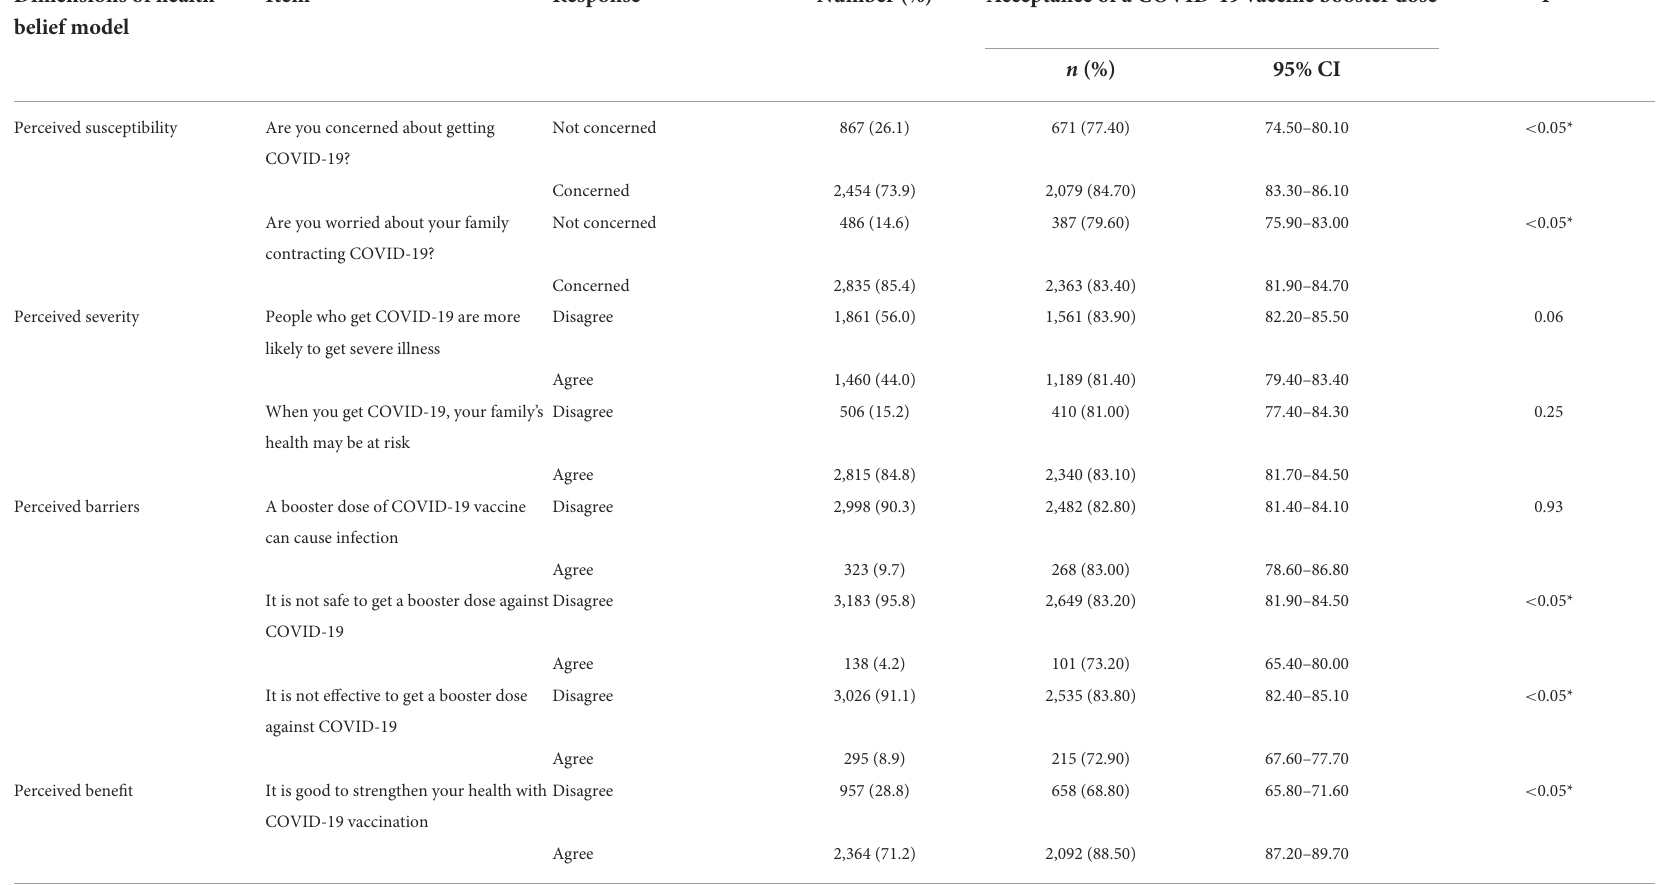
TABLE 2 Comparison of the acceptance rate of the COVID-19 vaccine booster dose based on the health belief model among the elderly population in China ( n = 3,321). Dimensions of health belief